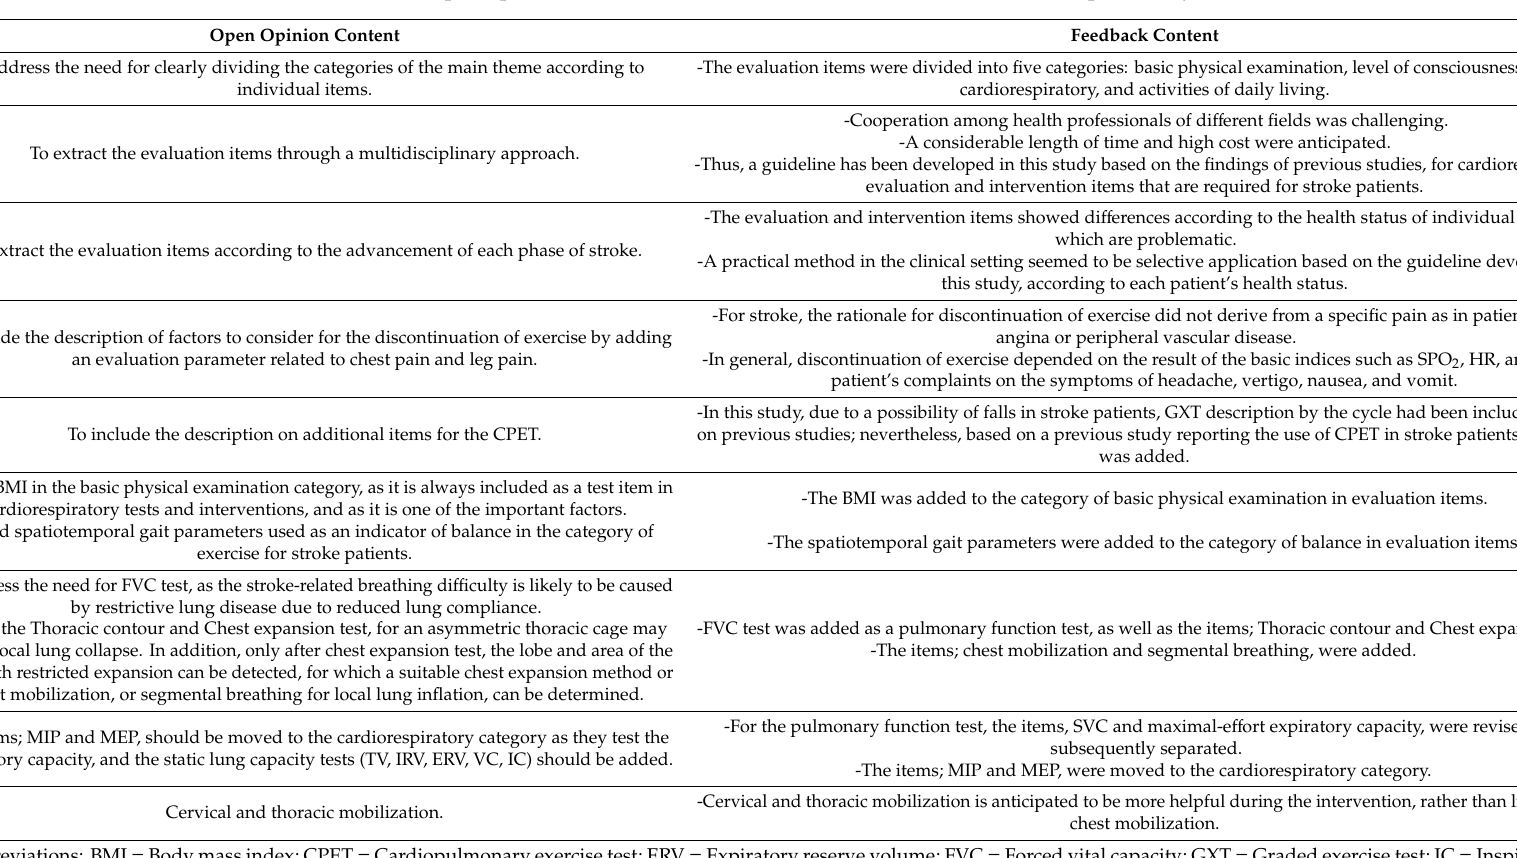
Table 10. Open opinions and researcher feedback after the first modified Delphi